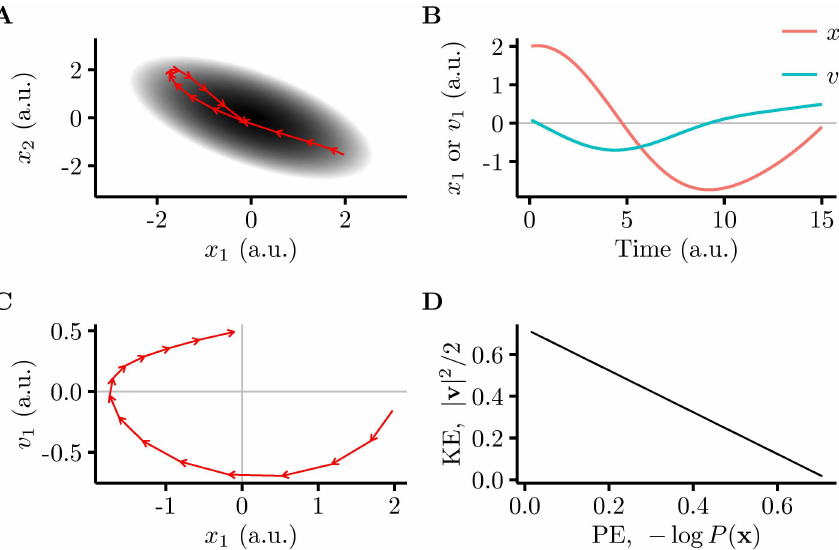
Fig 1. An example of Hamiltonian dynamics. A. Movement of a particle under Hamiltonian dynamics (i.e. with momentum) on a two-dimensional quadraticpotential energy landscape(greyscale, darker means lower energy) corresponding to a multivariate Gaussianprobabilitydensity. The red arrows show the trajectory, with each arrow representingan equal time interval. Note that the particle does not just go to the lowest potential energylocation: it picks up momentum (kinetic energy) as it moves, leadingit to oscillatearoundthe energy well. B. A plot of position (red) and velocity (blue, the derivative of position)along one dimension. C. Plotting velocity and positiondirectly against each other reveals explicitlythat the dynamicsof the system is similar to that of a harmonic oscillator. D. Plotting kinetic energy (KE) against potential energy (PE) revealsan exchangebetweenkinetic energy and potential energy that contributes to the system’s oscillatorybehaviour.